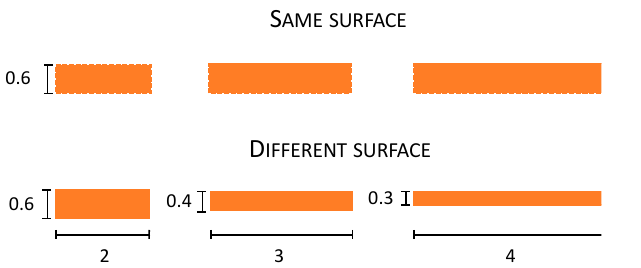
Figure 4. Depiction of the size of the different surfaces of the objects (same and different) used in Experiment 3. Numbers in the figures represent the dimension of the objects in centimetres (cm).